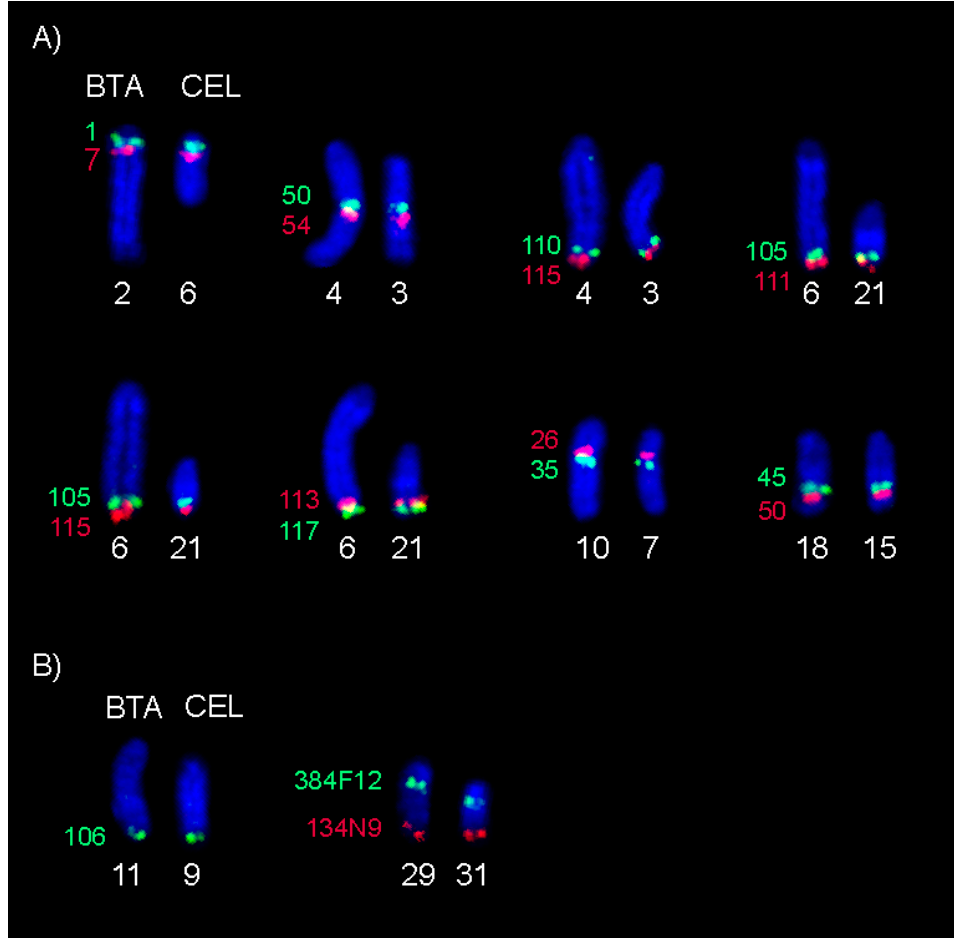
Figure 3. BAC-FISH mapping of the selected regions showing different gene order in CerEla1.0 and ARS-UCD1.2 genome assembly. Numbers indicate the BAC positions (Mb) on individual BTA chromosomes. ( A , B ) Identical signal order on orthologous bovine and red deer chromosomes. ( B ) Signal of the BAC probe CH240-134N9 on BTA29 and CEL31 instead of BTA11 and CEL9.